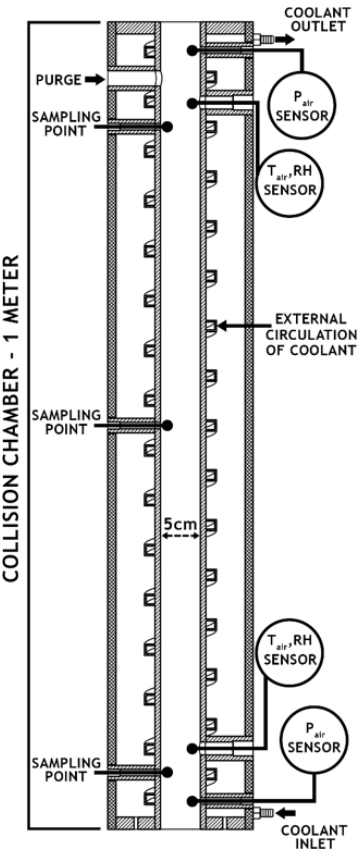
Figure 5. In-CASE collision chamber – 2D section plane.